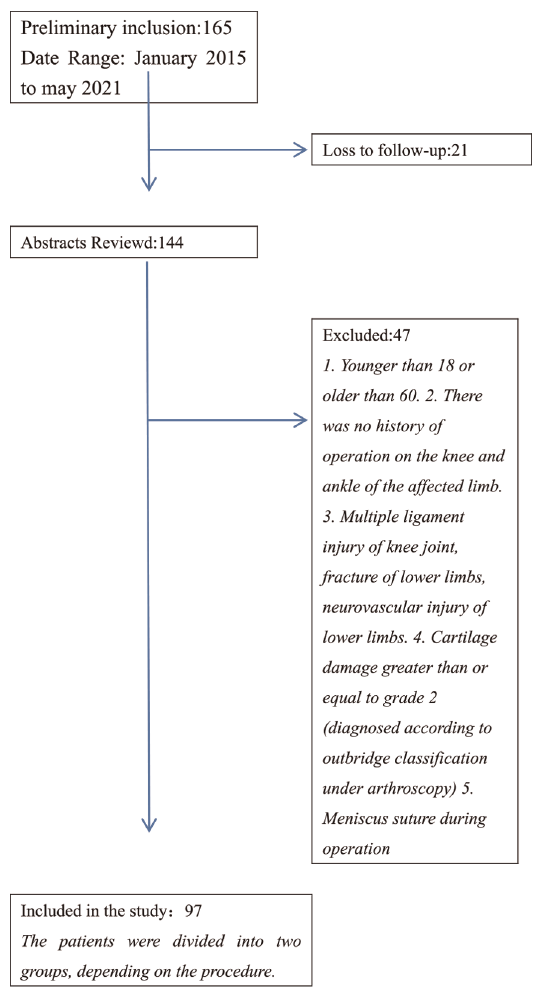
TABLE 1 Exclusion criteria and inclusion